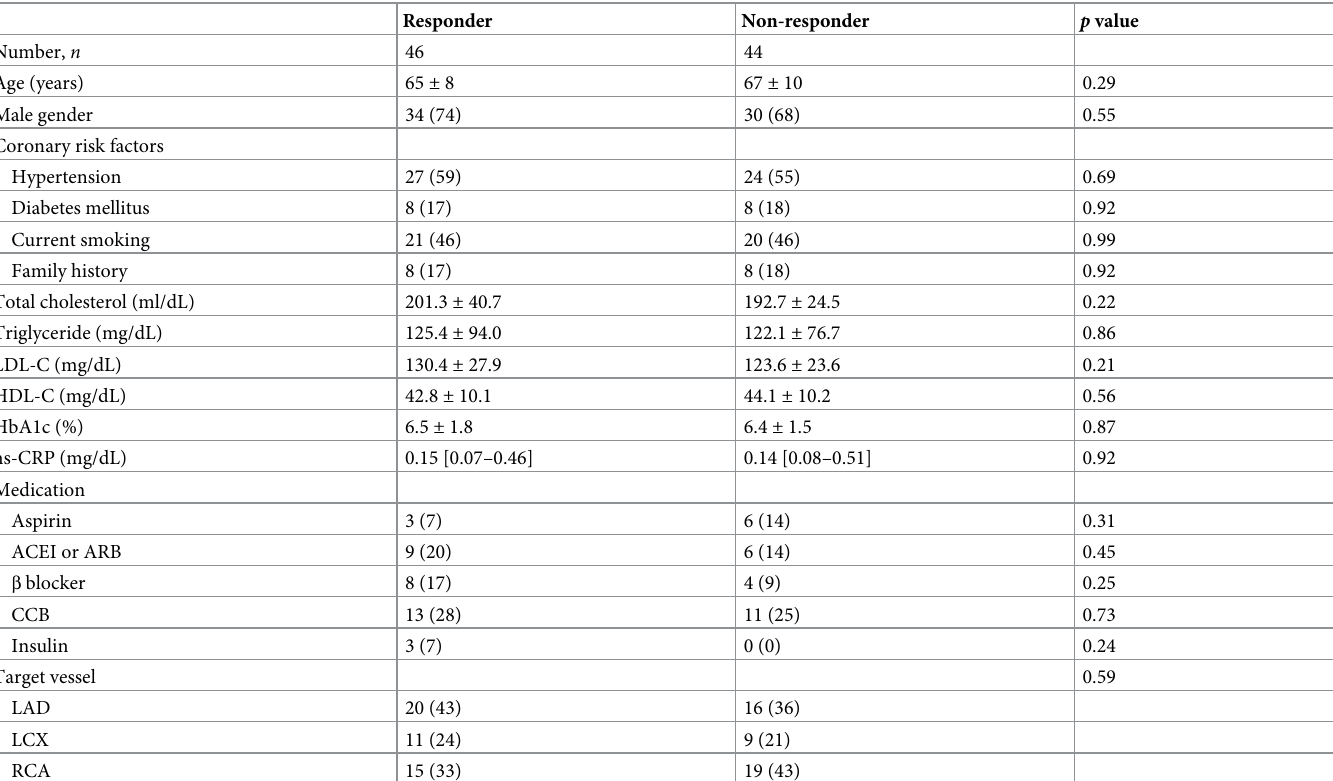
Table 1. Baseline characteristics.